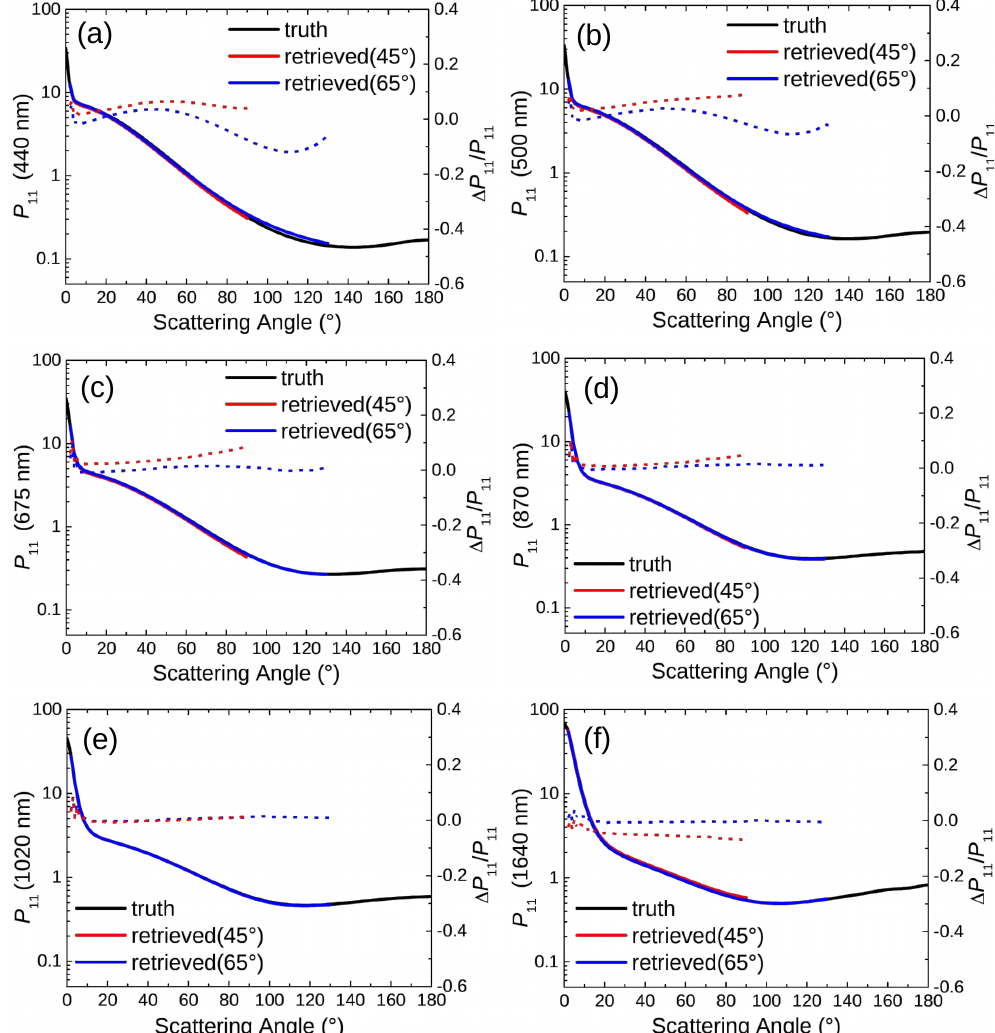
Figure 3. Comparison of P 11 retrieved from the Stokes parameter I at different solar zenith angles for the almucantar observation geometry. The curve notation is as: red solid lines for results of P 11 with SZA of 45 0 ; red dashed lines for relative errors with SZA of 45 0 ; blue solid lines for results of P 11 with SZA of 65 0 ; blue dashed lines for relative errors with SZA of 65 0